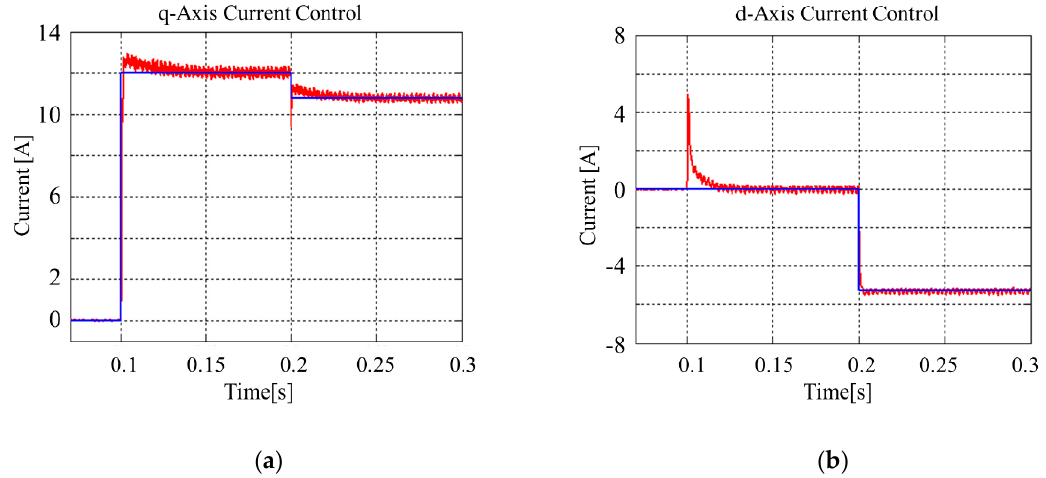
Figure 12. Input current reference between without MTPA and with MTPA: ( a ) q-axis and ( b ) d-axis.